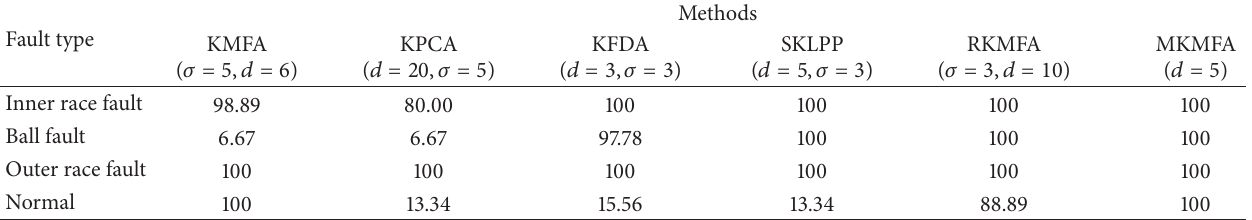
Table 2: The recognition rates (%) of KNN classifier based on six feature extraction